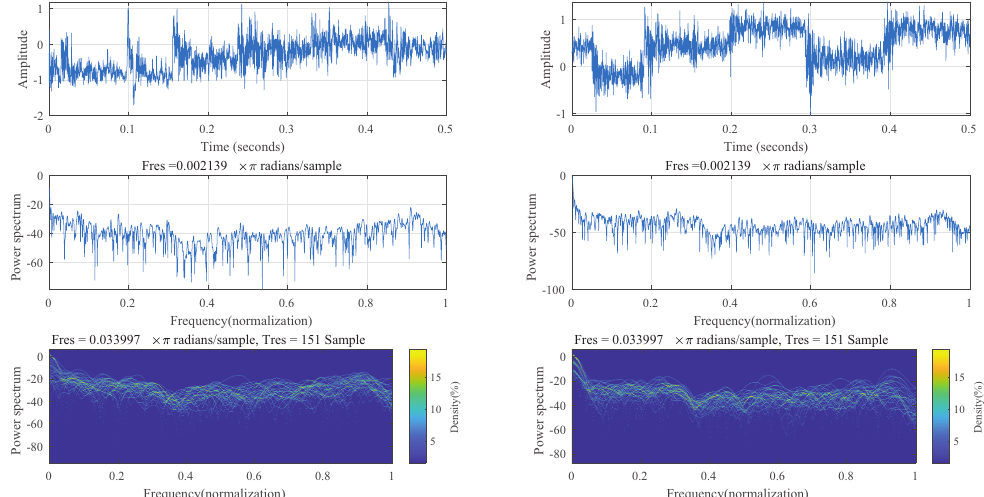
Figure 6. Time domain and frequency domain of two randomly selected welding signals (First row: Time-domain diagram; Second row: Normalised frequency spectrum; Third row: Normalised persistent frequency